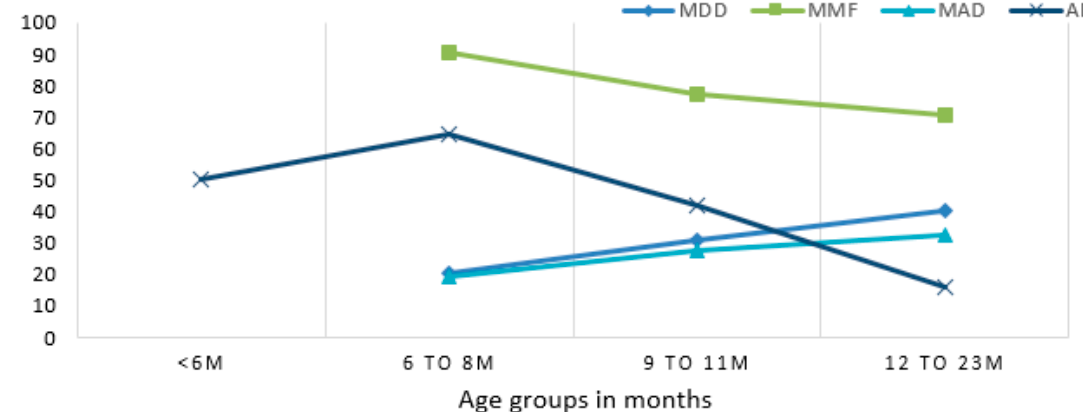
Figure 3. Percentage of age-appropriate feeding practices by child’s age groups. MDD = minimum dietary diversity; MMF = minimum meal frequency; MAD = minimum acceptable diet; and ADF = age-appropriate daily feeding.